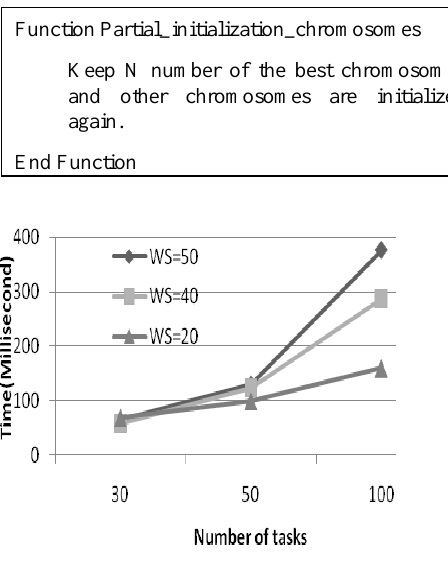
Figure 12. Performance of GA based algorithm